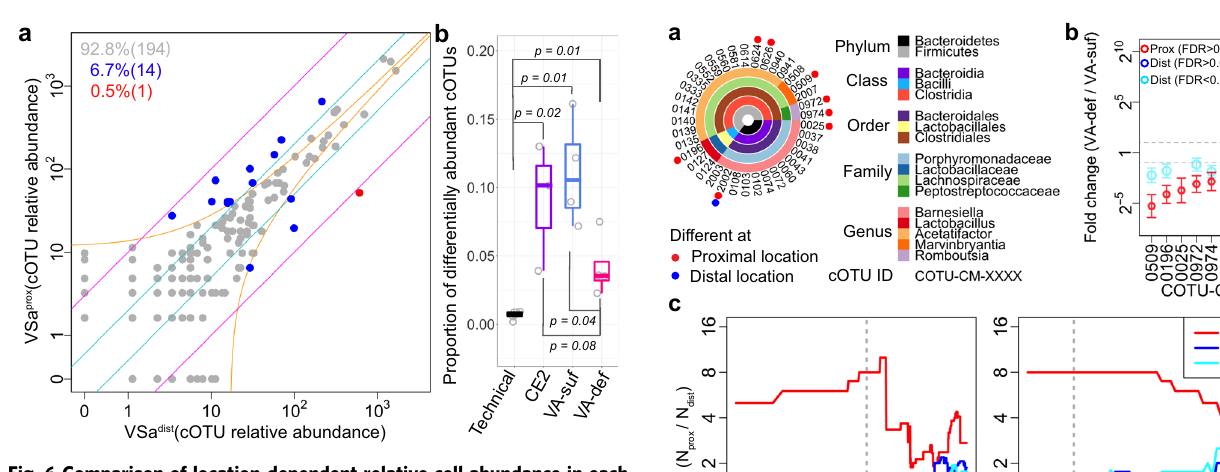
Fig. 6 Comparison of location-dependent relative cell abundance in each mouse. a Comparison between the relative cell abundances of cOTUs detected from the distal location and proximal location of the mouse VSa, shown in Fig. 4a (other mice in Supplementary Fig. 16a). b Proportion of location-dependent differentially abundant cOTUs (differences were larger than the sampling noise and 2-fold) in each mouse. Technical, all pairs from three technical replicates within the distal and proximal locations for the mouse CEa; CE2, the mice in the CE2 nutriment group; VA-suf, the mice in the VA-suf fi cient group; VA-def, the mice in the VA-de fi cient group. Boxes represent 25th to 75th percentiles (the interquartile range), horizontal black lines indicate medians, and whiskers show 1.5 times the interquartile range ( n = 6 for Technical, n = 3 for CE2, n = 4 for VA-suf and VA-def). P values were calculated by the Kruskal – Wallis rank-sum test. Source data are provided as a Source Data fi le.